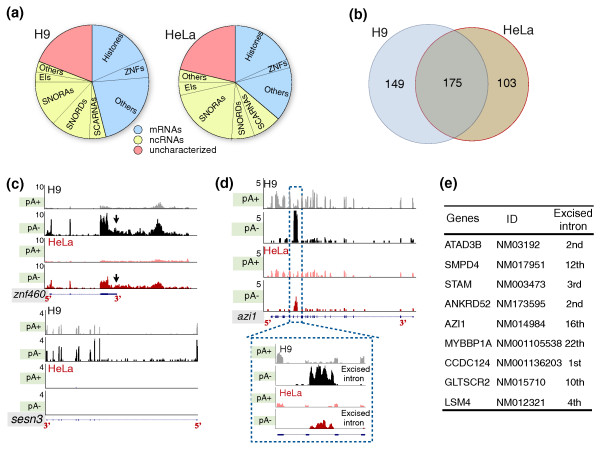
Classification of poly(A)- transcripts. (a) Classification of poly(A)- transcripts: EIs, excised introns; ZNF, zinc finger factor protein family. See text for details. (b) Overlapping analysis of the expression of poly(A)- transcripts in H9 and HeLa cells. (c) Example of a poly(A)- non-histone mRNA, znf460 and sesn3. The relative signals from either poly(A)+ or poly(A)- RNA preparations were normalized to those in the total RNA preparation in each cell line. Note that the signals from the poly(A)- samples are significantly enriched. Black arrows show the extended unannotated 3' UTR region of znf460. (d) An example of the excised 16th intron of the mRNA azi1. The blue box reveals the information in detail from this region. Note that the excised intron is abundant and can be detected only in the poly(A)- samples. (e) Examples of excised introns from different mRNAs, and the position of the excised intron in each mRNA is indicated.